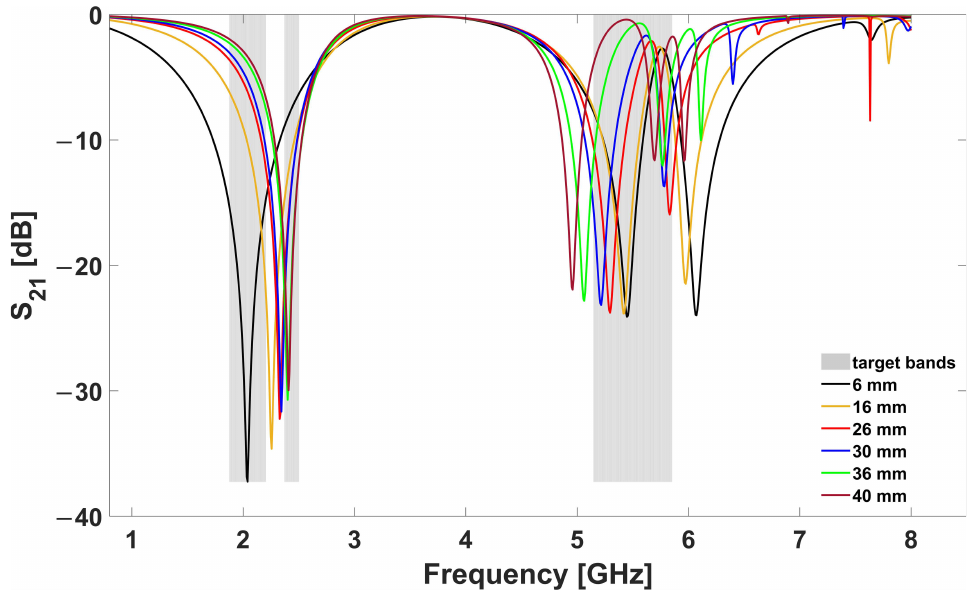
Figure 8. Simulated effect of increasing inter-element spacing ( d ) under Floquet mode boundary